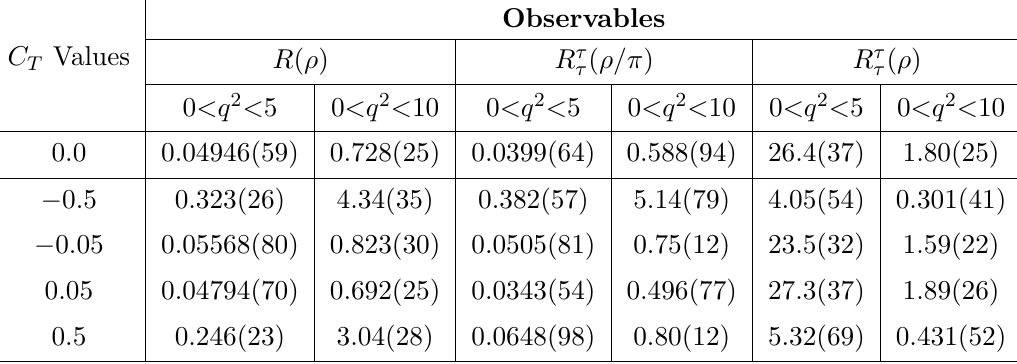
Table 15. Values for observables related to the B → ρ transition for different values of the tensorial NP C . The tensorial form factors that cannot be constrained from a fit to the B → ρµν binned T branching ratios are constrained purely from the LCSR data valid upto q 2 = 10 GeV. The results have hence been presented in two q 2 bins [0,5] and